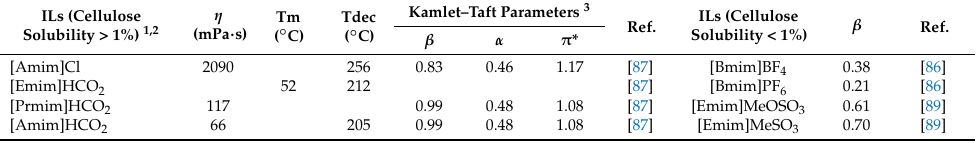
ILs capable of dissolving cellulose (modified from [83] and molecular-microscopic properties measured at 25 ◦ C: hydrogen-bonding acidity ( α ), hydrogen-bonding basicity ( β ), dipolarity/polarizability ( π *) and physical properties: viscosity at 25 ◦ C ( η ), melting temperature (Tm), decomposition temperature